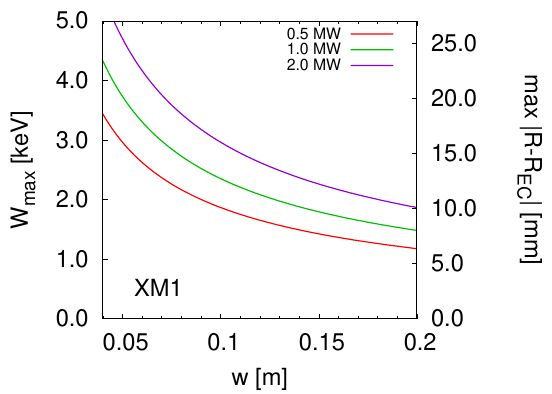
Figure 6. Radial energy profile for XM1 perpendicular propaga- tion and P EC = 0 . 5 , 1 MW in ITER, with R EC ≈ 5 . 41 m at full field B 0 = 5 . 3 T.